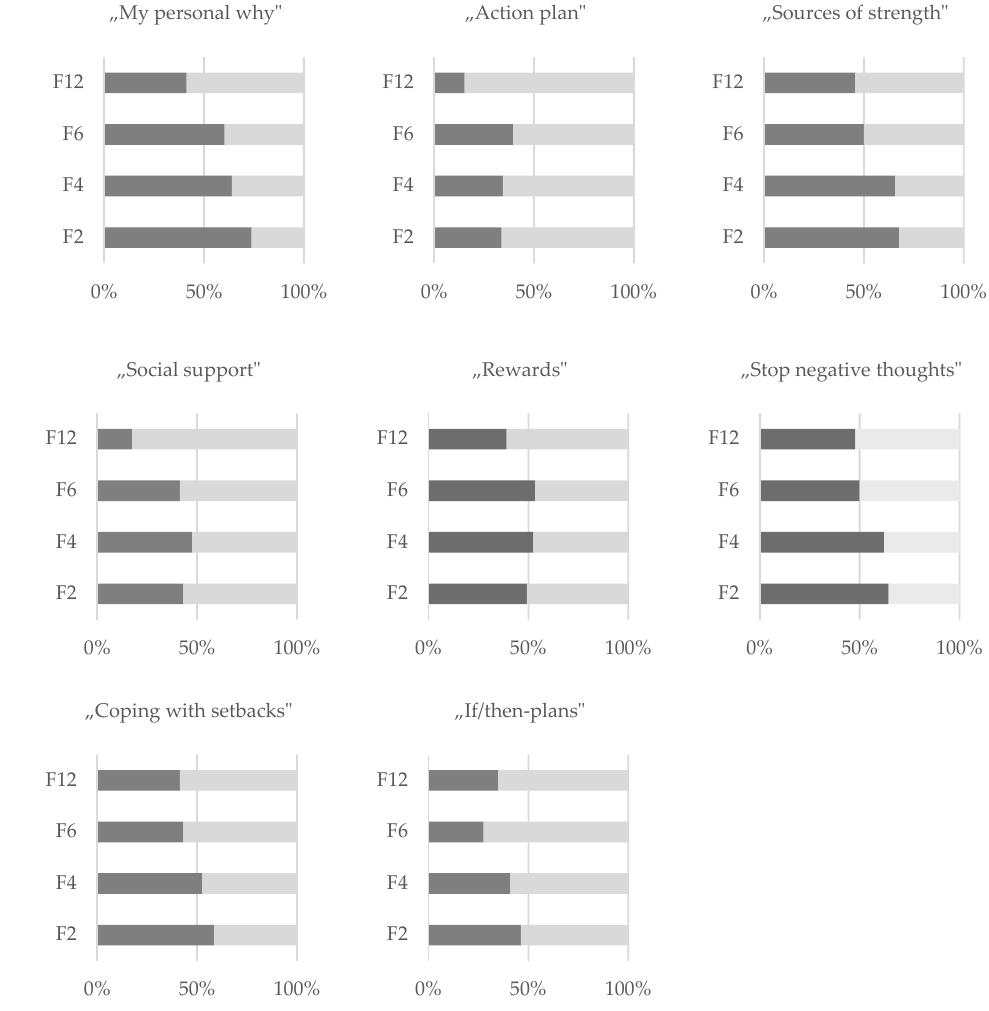
Figure 5. Application of different components of the rubric “my focus”. Abbreviations: F2 = two months after the intervention; F4 = four months after the intervention; F6 = six months after the intervention; F12 = twelve months after the intervention.